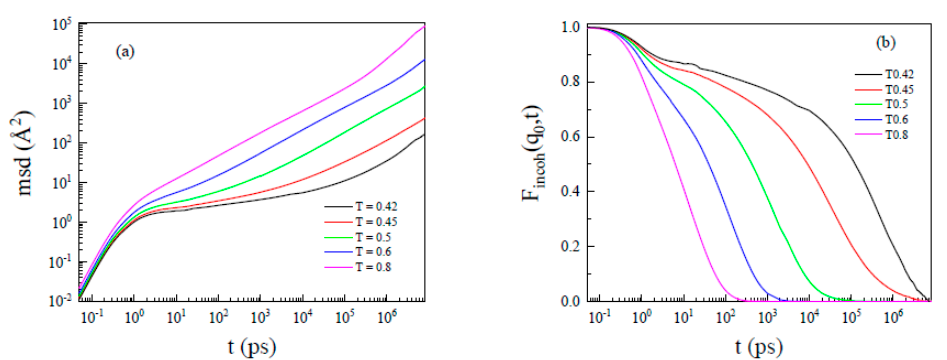
Figure 5. ( a ) Mean square displacements of monomers at different temperatures. ( b ) Incoherent intermediate scattering function of monomers at different temperatures. With the decrease in the temperature, α / β split happens, and it becomes evident when T = 0.45.